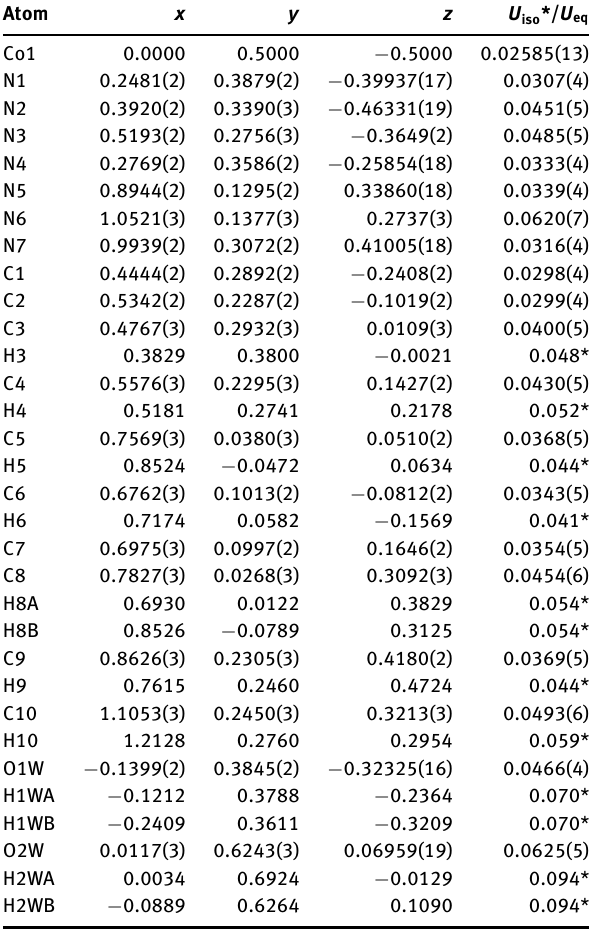
Table 2: Fractional atomic coordinates and isotropic or equivalent isotropic displacement parameters (Å 2